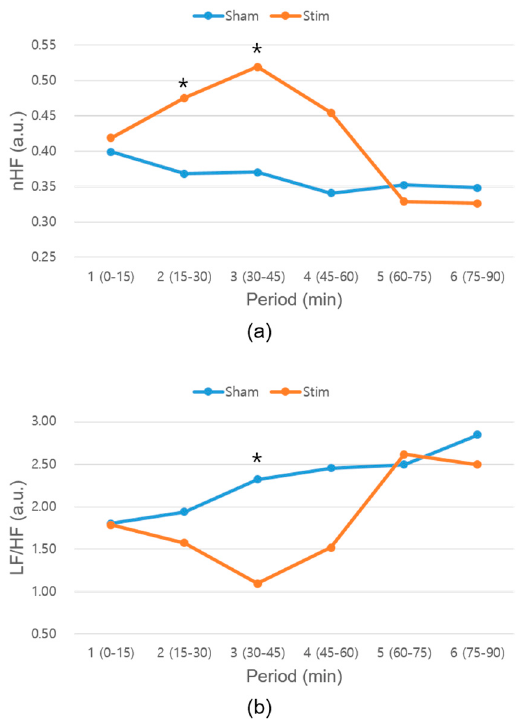
Figure 7. Results of the HRV extracted every 15 min under the baseline and − 3% stimulation conditions: ( a ) nHF and ( b ) LF / HF parameter results. HRV—heart rate variability; nHF—normalized high-frequency band power; LF / HF—ratio of the low-frequency power to the high-frequency